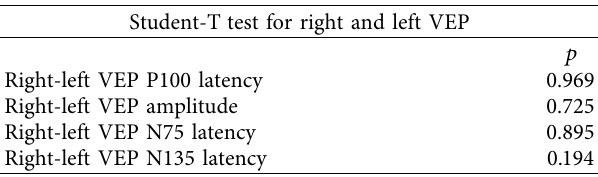
Table 5: Comparison between right and left eye VEP variables of PD